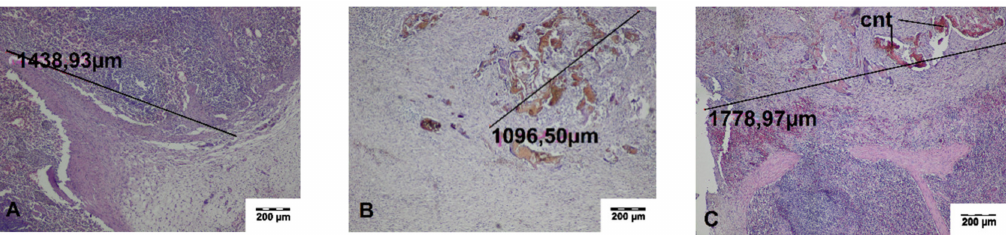
Figure 8. Histopathological sections of the spleen on day 14 after cutting with the diode laser (DL) (HE staining). Black lines indicate the width of the entire zone of thermal damage. ( A ) Site of omentum adhesion to the wound, a band of the fibrous connective tissue penetrating the spleen parenchyma are visible (magnification × 40); ( B , C ) residues of carbonized tissue surrounded by the connective tissue with proliferating splenocytes (magnification × 40). cnt, carbonized necrotic